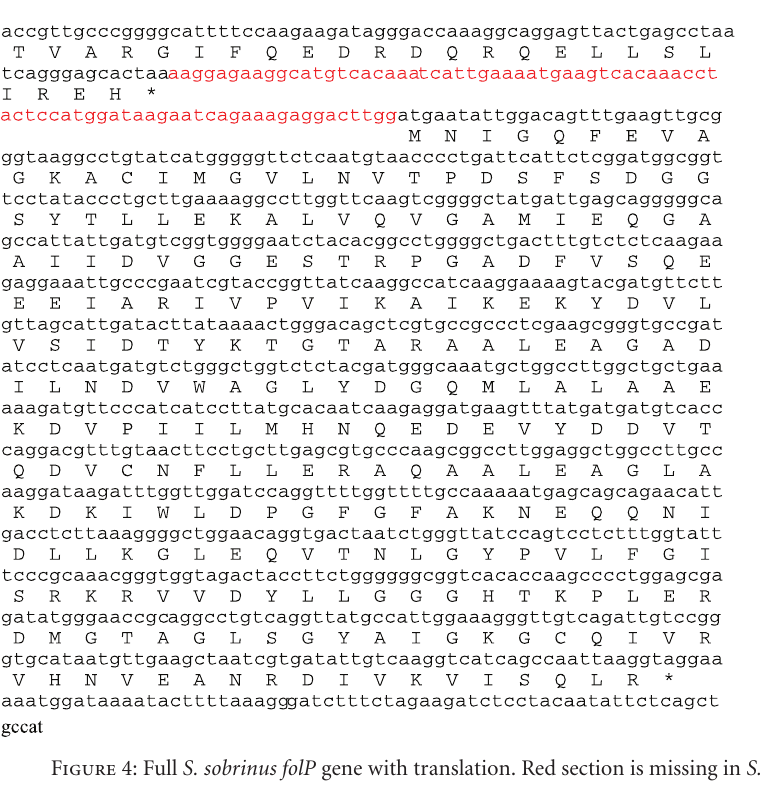
Figure 4: Full S. sobrinus folP gene with translation. Red section is missing in S. downei .